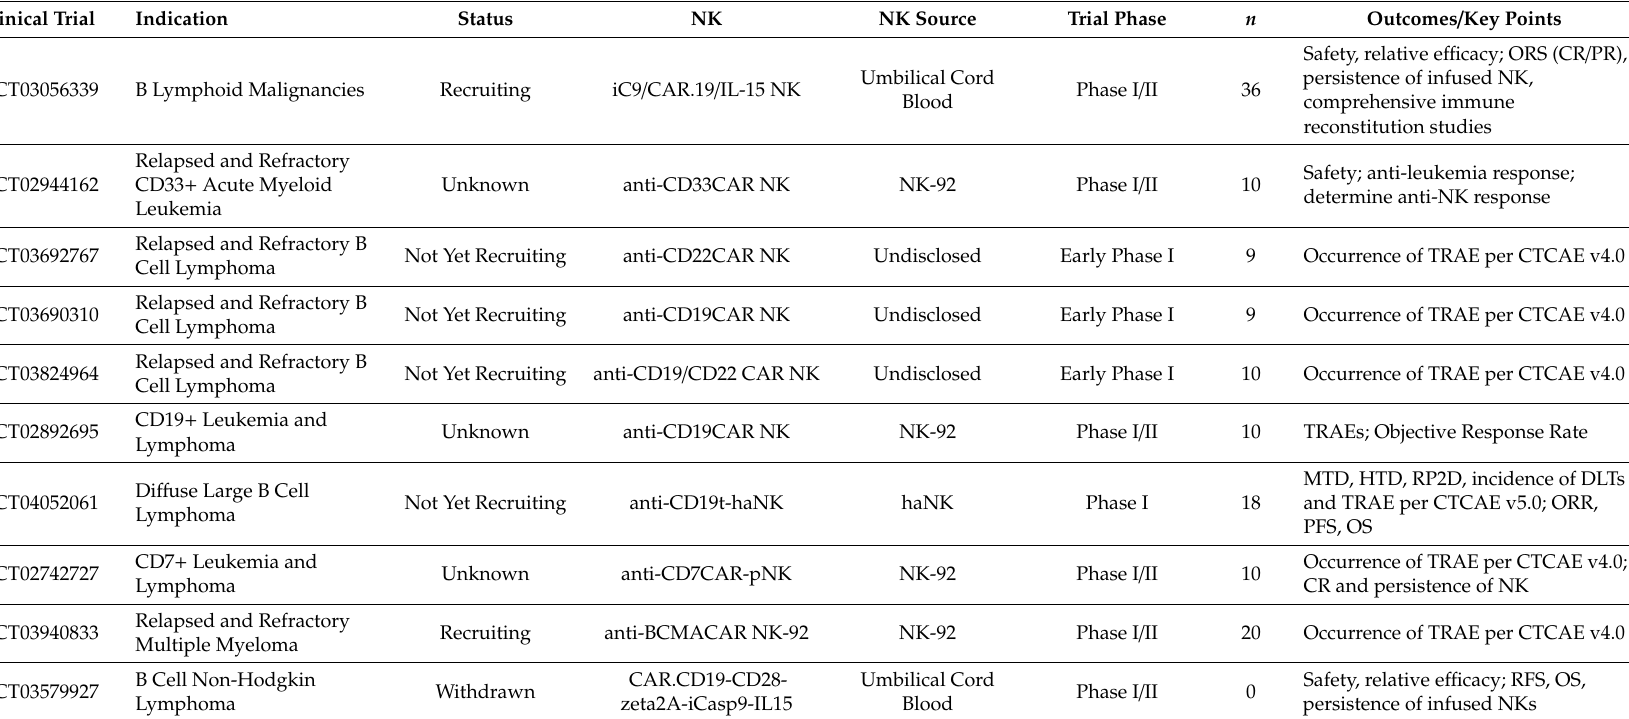
Table 1. Clinical trials in Hematologic Malignancies using CAR-NK